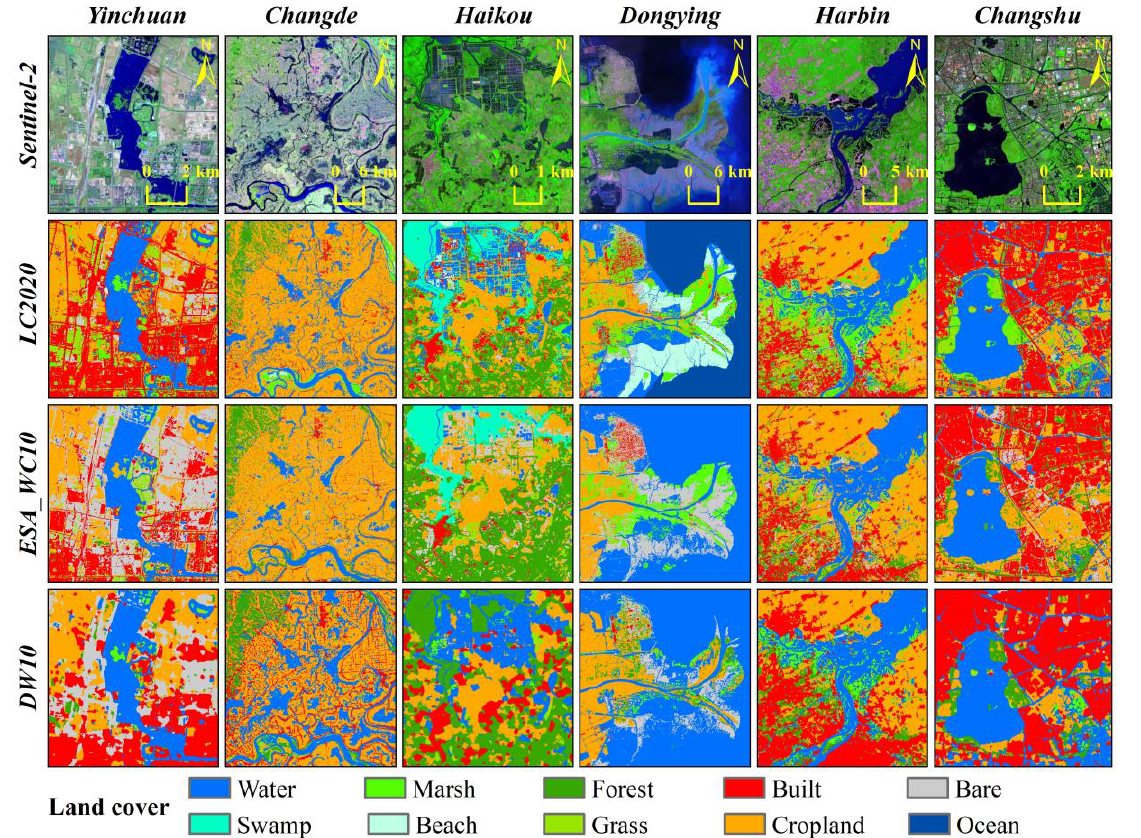
Figure 5. Visual comparison of this study (LC2020) with Sentinel-2 RGB, ESA_WC10 and DW10 products for the typical areas of 6 cities in 2020.